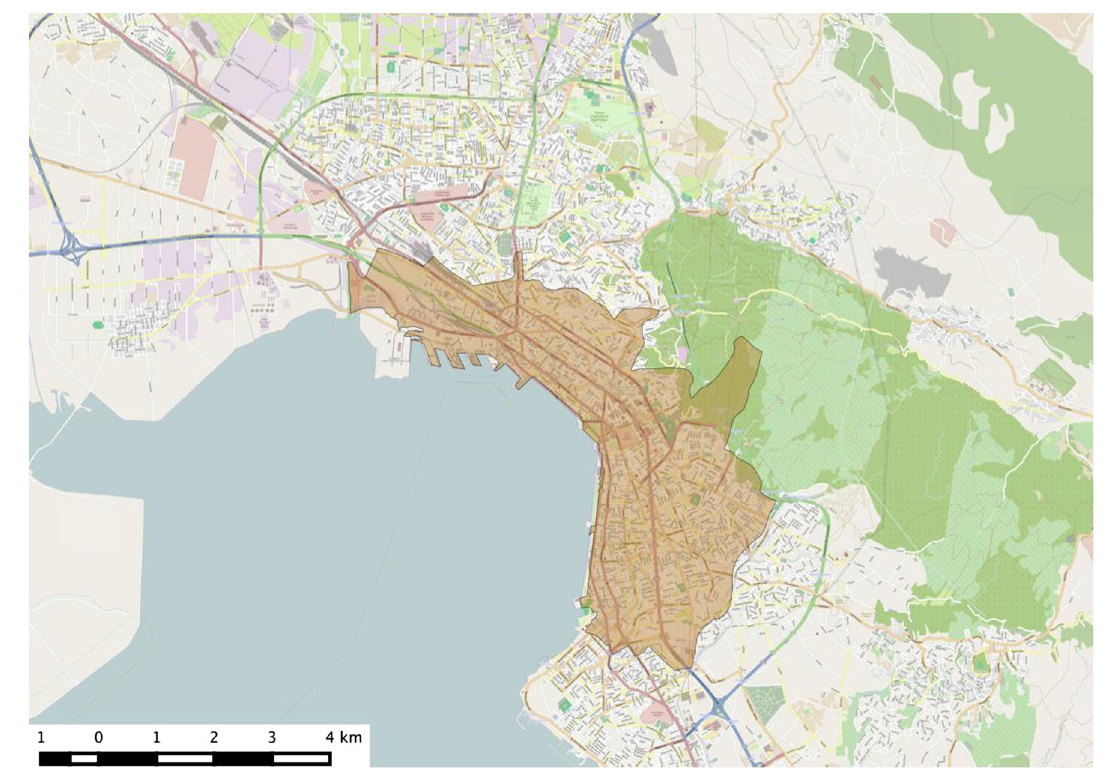
Fig. 1 Municipality of Thessaloniki (orange colored